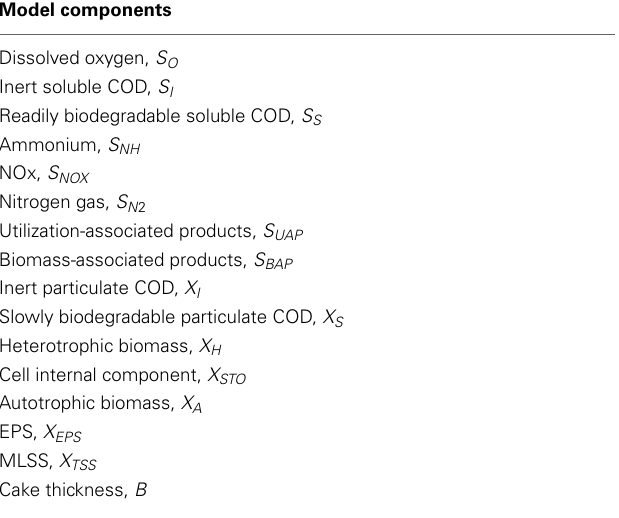
Table 1 | Model state variables.